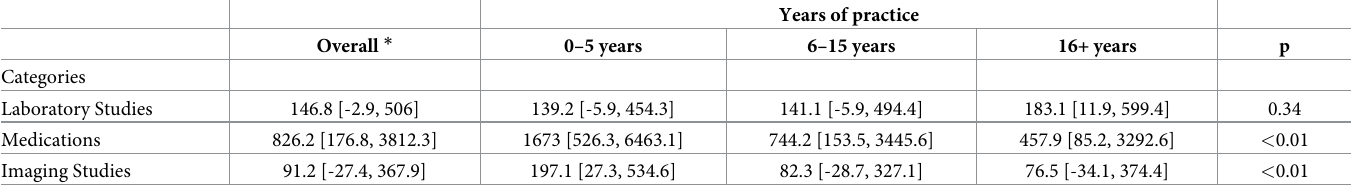
Table 6. Median [interquartile range] percent difference and years of